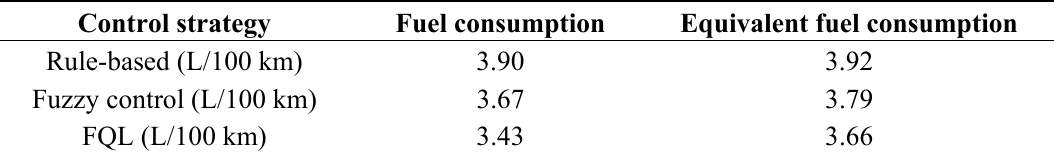
Table 5. Compare results under